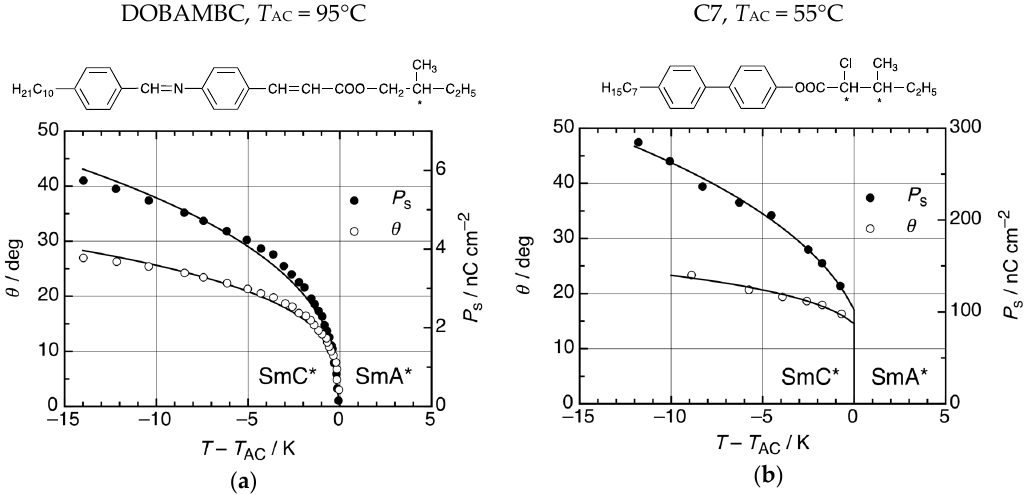
Figure 5. Two examples of ferroelectric SmC* materials. ( a ) The chiral Schiff base DOMBAMBC has a second-order SmA* – SmC* transition at the transition temperature T AC = 95 °C. At increasing temperatures T < T AC , the director tilt angle 𝜃 and the spontaneous electric polarization P s continuously decrease to zero values at T = T AC . At that critical point, the SmC* phase is identical to SmA*. (Data taken from [16].) ( b ) The chiral biphenyl C7 has a first-order SmA* – SmC* transition. At T AC , the paraelectric SmA* phase coexists with a ferroelectric SmC* phase with non-zero 𝜃 and P s .